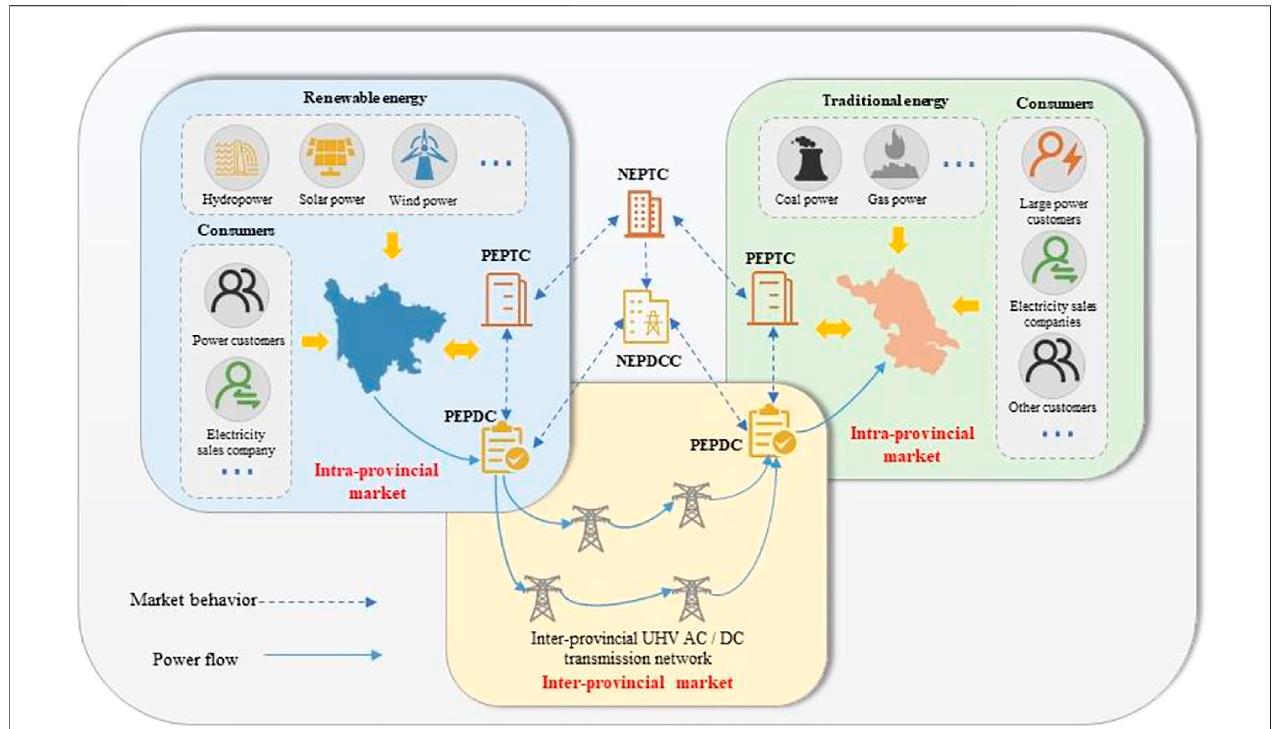
FIGURE 1 | Framework of a two-tier electricity market considering renewable energy accommodation.